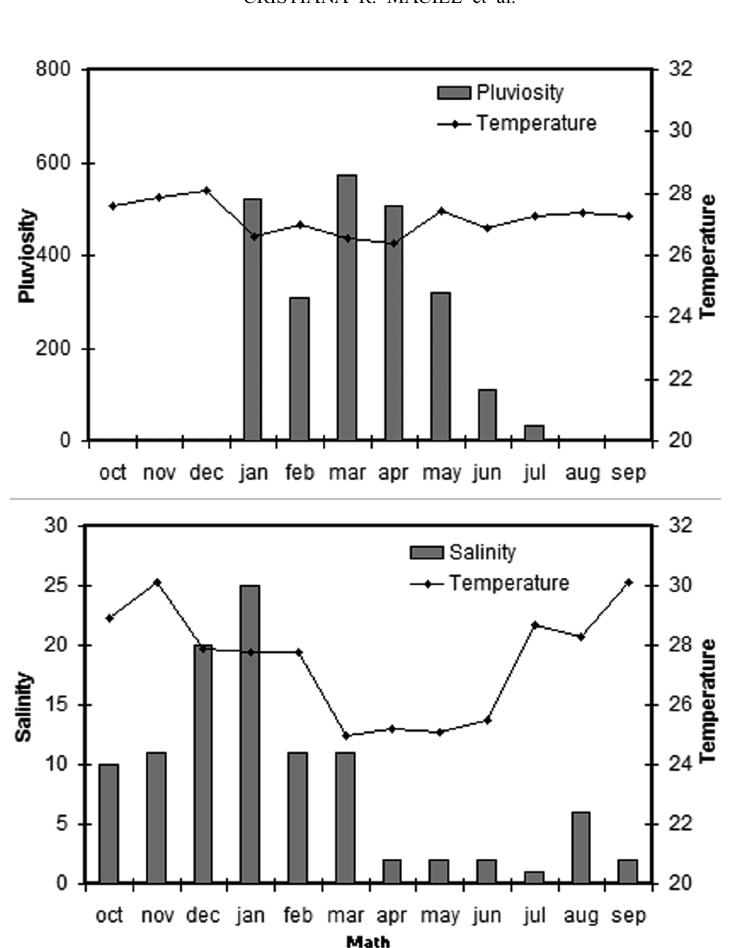
Fig. 4 – Monthly precipitation and average air temperature (above) and salinity and water temperature (below) recorded each month in the Caeté Estuary between October 2001 and September 2002.